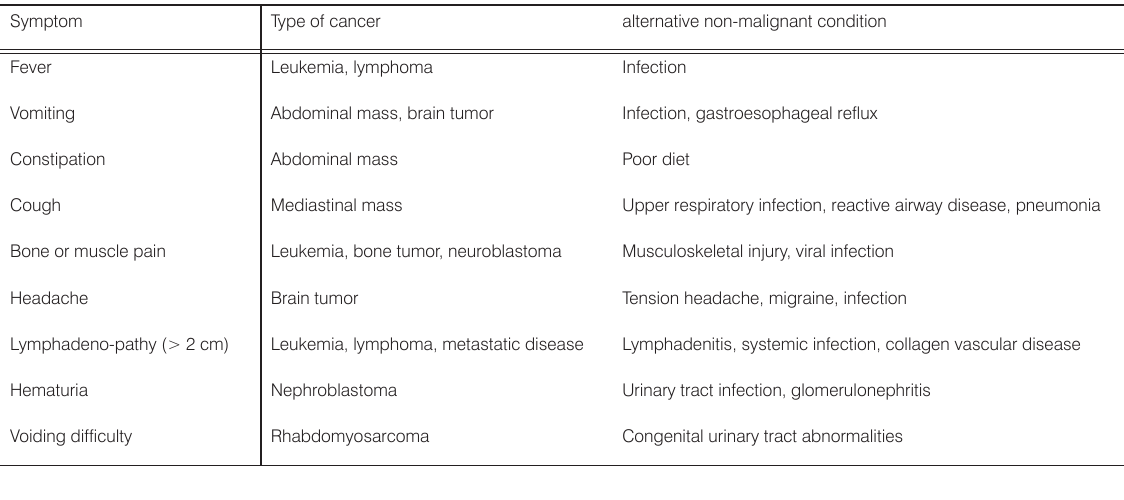
Table 1. Cancer symptoms and alternative non-malignant conditions in the differential diagnosis [ 24 ]